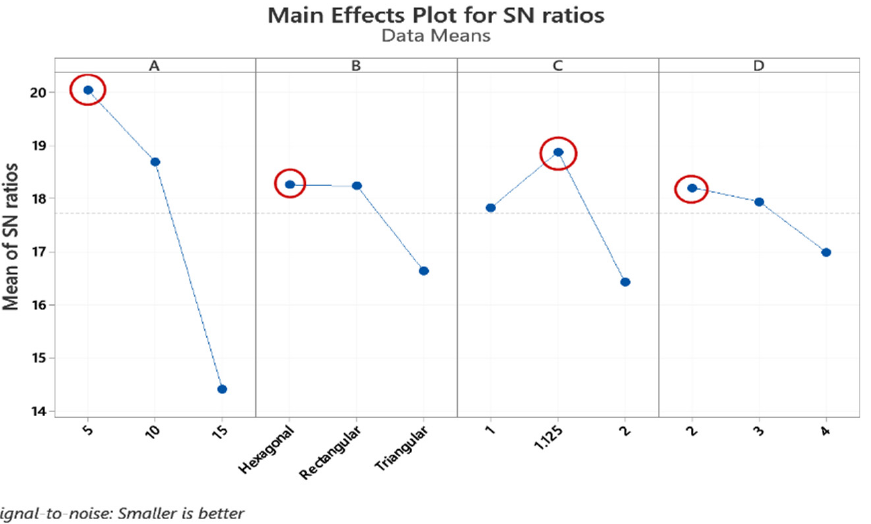
Figure 5. Main effect plot circularity. A, B, C, and D represent the Thickness, Infill Pattern, Layer height, and Wall Layer, respectively.